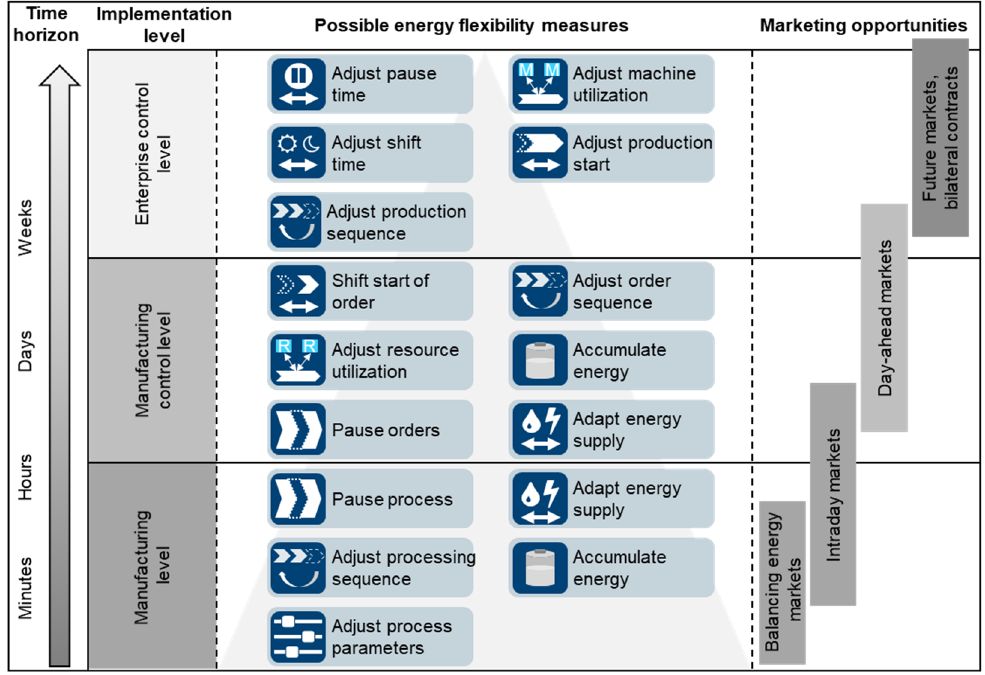
Figure 1. Energy flexibility measures allocated to their levels of implementation in the energy-flexible factory and their corresponding marketing opportunities (own illustration based on [10,14,15]).